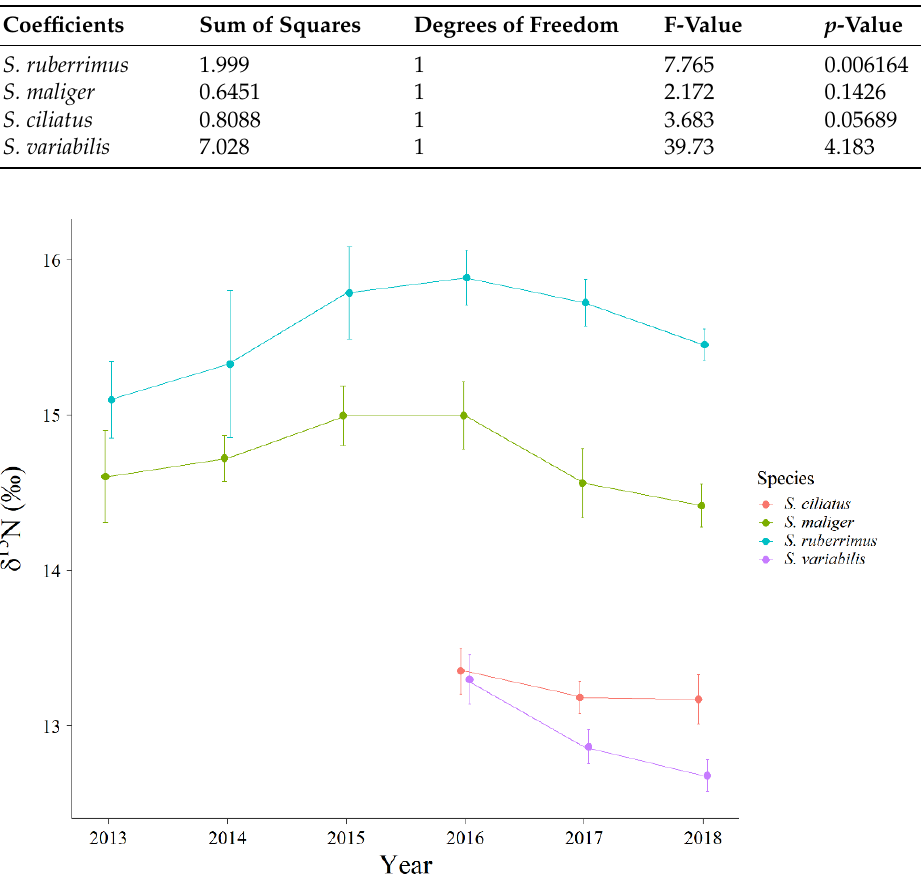
Figure 7. Mean shifts in δ 15 N and 95% confidence intervals across time for four rockfish species in this